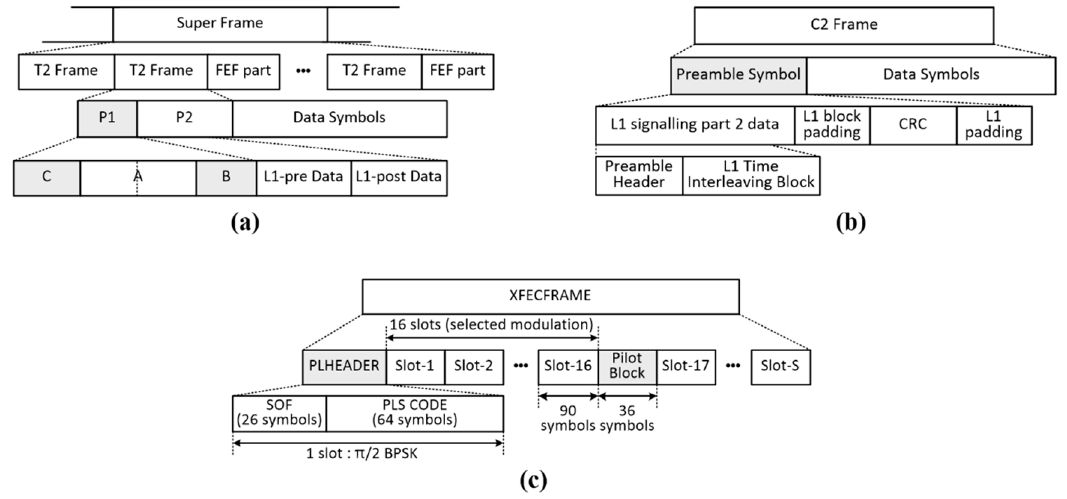
Figure 2. Frame structures of ( a ) DVB-T2, ( b ) DVB-C2, and ( c ) DVB-S2.